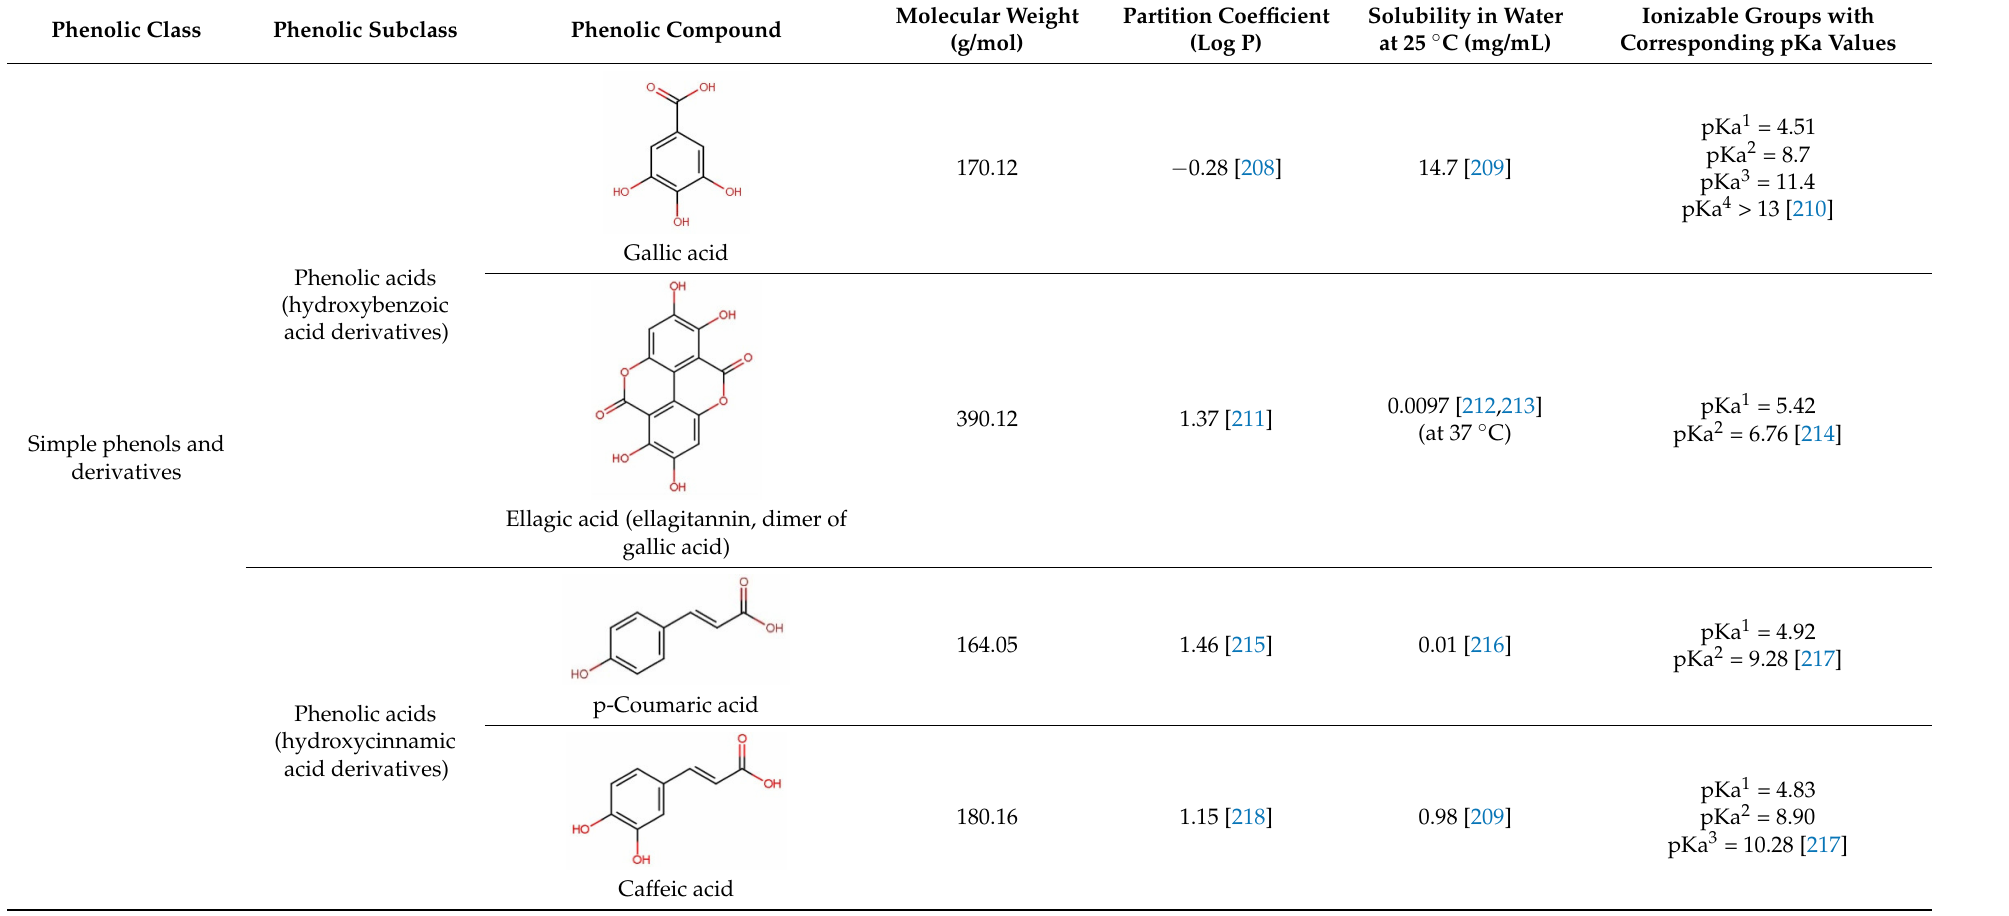
Table 1. Physico-chemical characteristics of selected phenolic